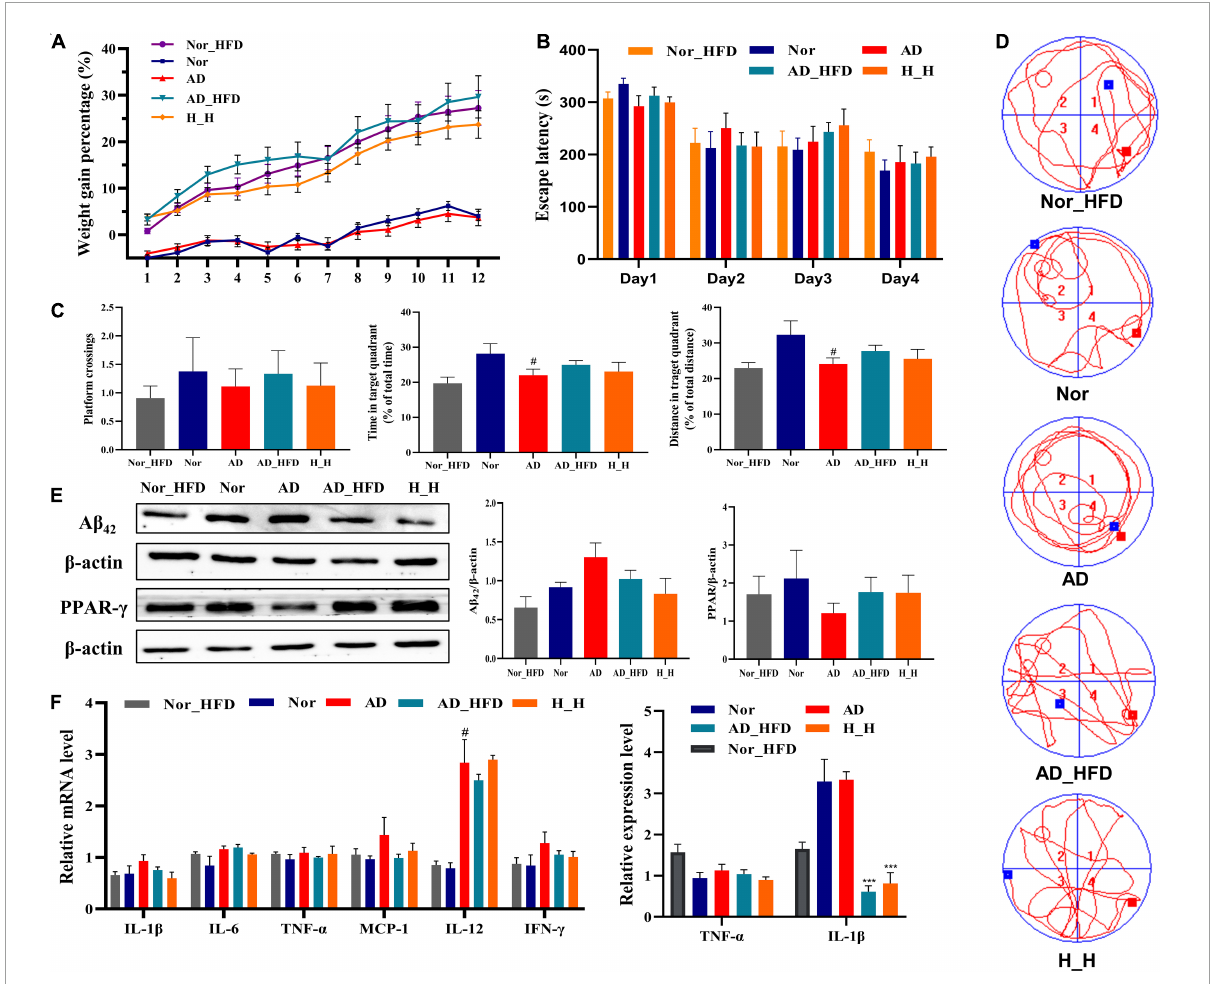
FIGURE1 The effect of HFD on APP/PS1 mice cognitive impairment. (A) The weight gain percentage with normal diet or HFD for 3 months, respectively. (B) Escape latency during spatial acquisition training. (C) The platform crossing number, distance traveled percentage in the target quadrant and time spent percentage in the target quadrant in the spatial probe test ( n = 10). (D) The real-time monitoring of mice motion track Morris Water Maze test experiment. (E) The relative protein concentration of A β 42 and PPAR- γ detected by WB ( n = 3). (F) The expression of inflammatory cytokine detected by RT-PCR and Elisa method in brain tissue. All the results are expressed as the mean ± SEM; # P < 0.05, ## P < 0.01, ### P < 0.001 (compared to the Nor group); * P < 0.05, ** P < 0.01, *** P < 0.001 (compared to the AD